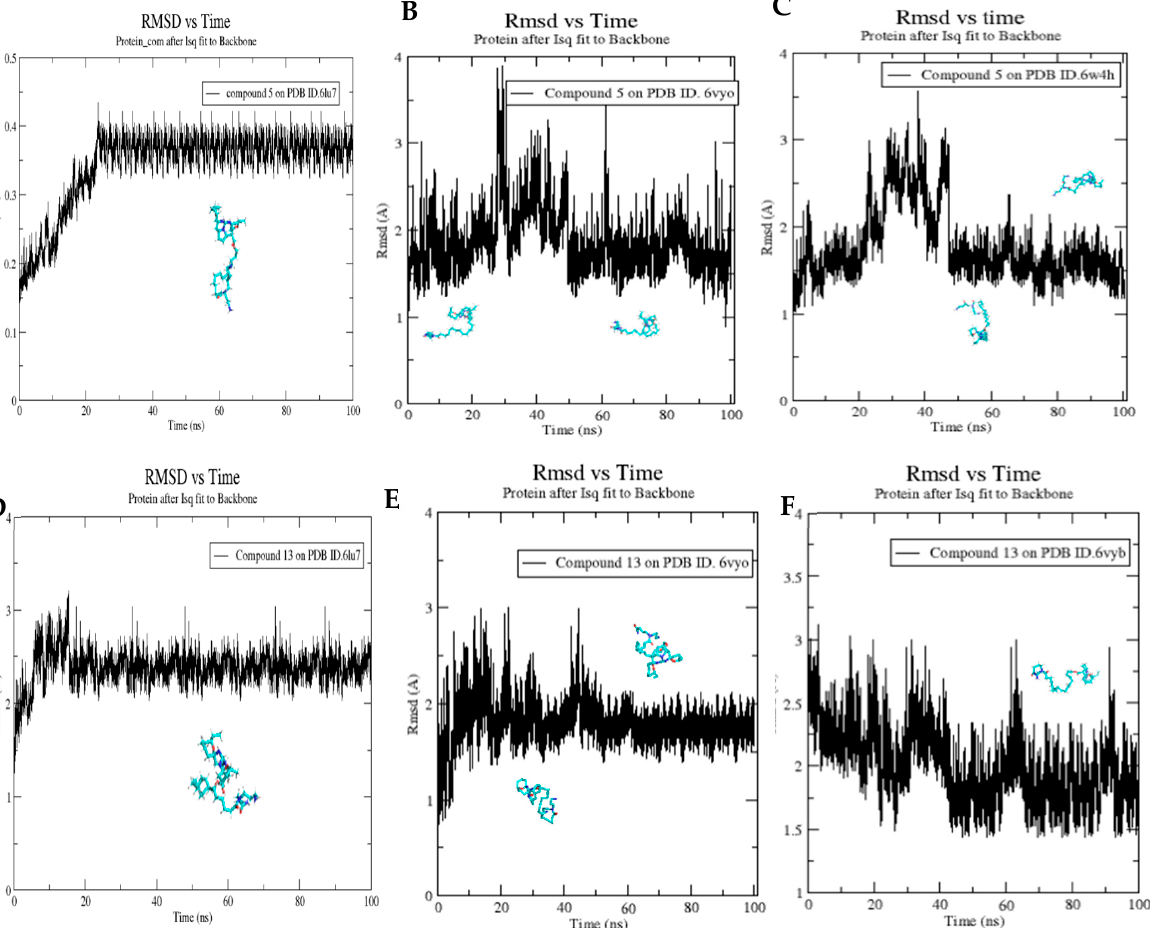
Figure 17. Molecular dynamics simulations of compound 5 bound to PDB ID. 6lu7 ( A ), 6VYO ( B ), and 6W4H ( C ), and compound 13 bound to PDB ID. 6lu7 ( D ), 6VYB ( E ), and 6VYO ( F ). RMSD analysis of compounds 5 and 13 binding with their biotarget proteins showing the most stable ligand conformers.